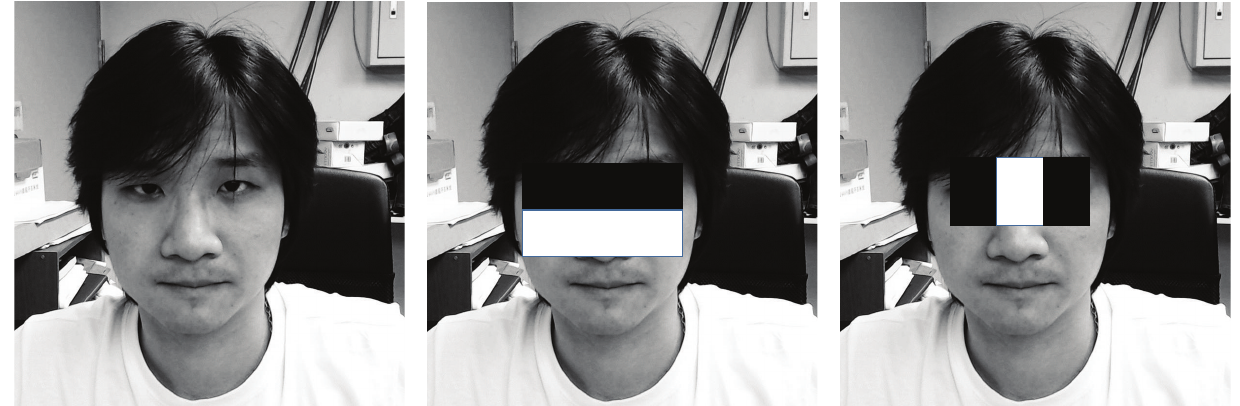
Figure 5: The example of applying the boosted cascade detectors with the Haar-like features on